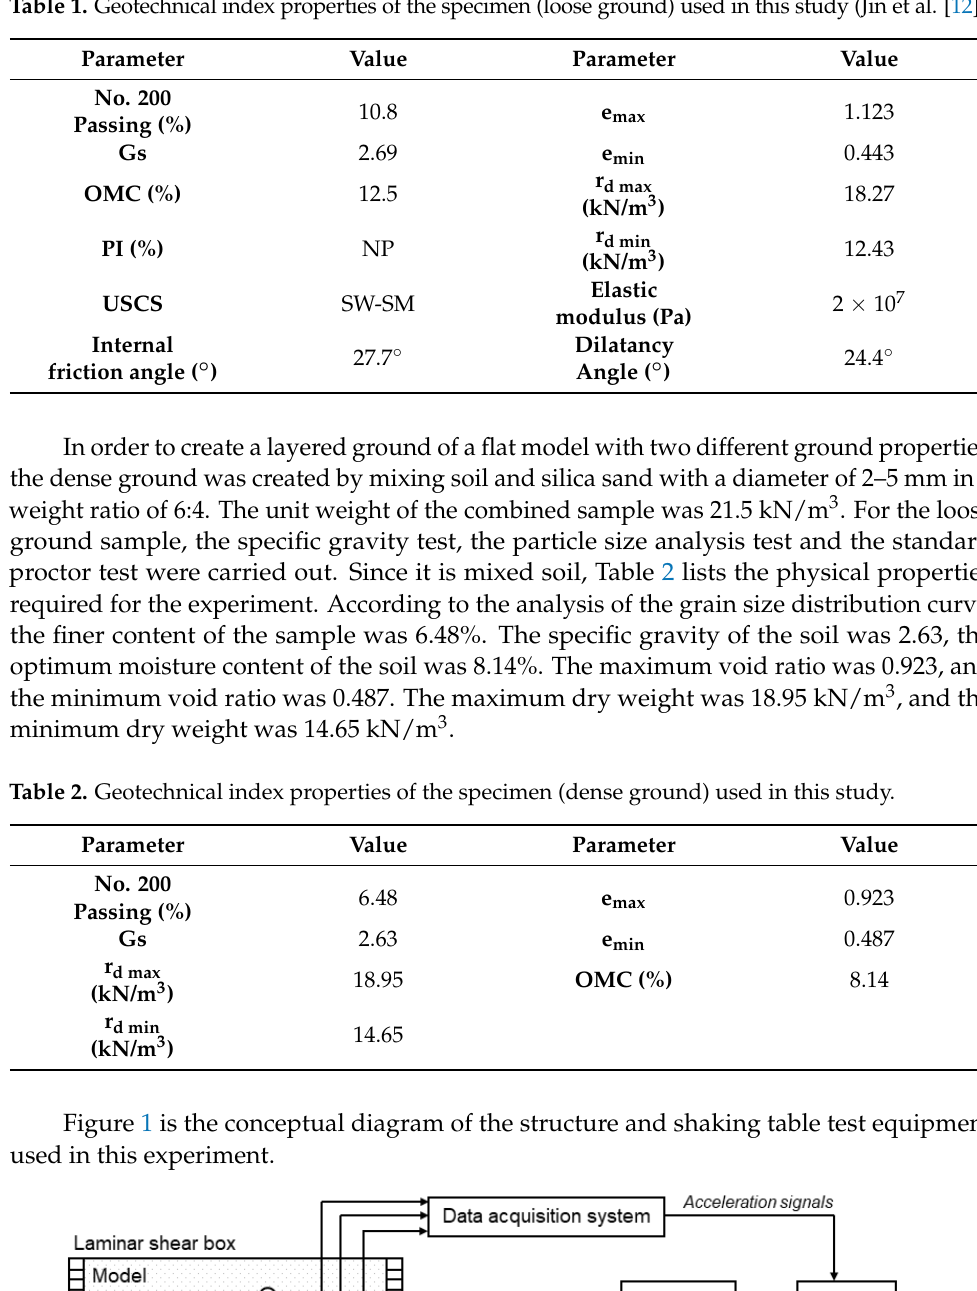
( d ) Figure 2. Laminar shear box: ( a ) Empty Laminar shear box in this study; ( b ) Soil sample set up in the LSB; ( c ) Accelerometer set up for a dense layer; ( d ) Accelerometer set up for a loose layer.